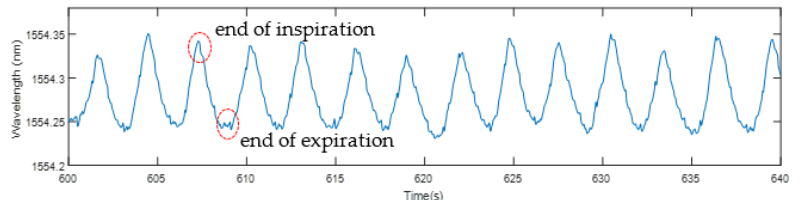
Figure 6. Results from one FBG sensor demonstrating the normal breathing pattern of a pregnant mother while resting. Peaks indicate the end of inspiration, whereas throughs indicate the end of expiration.